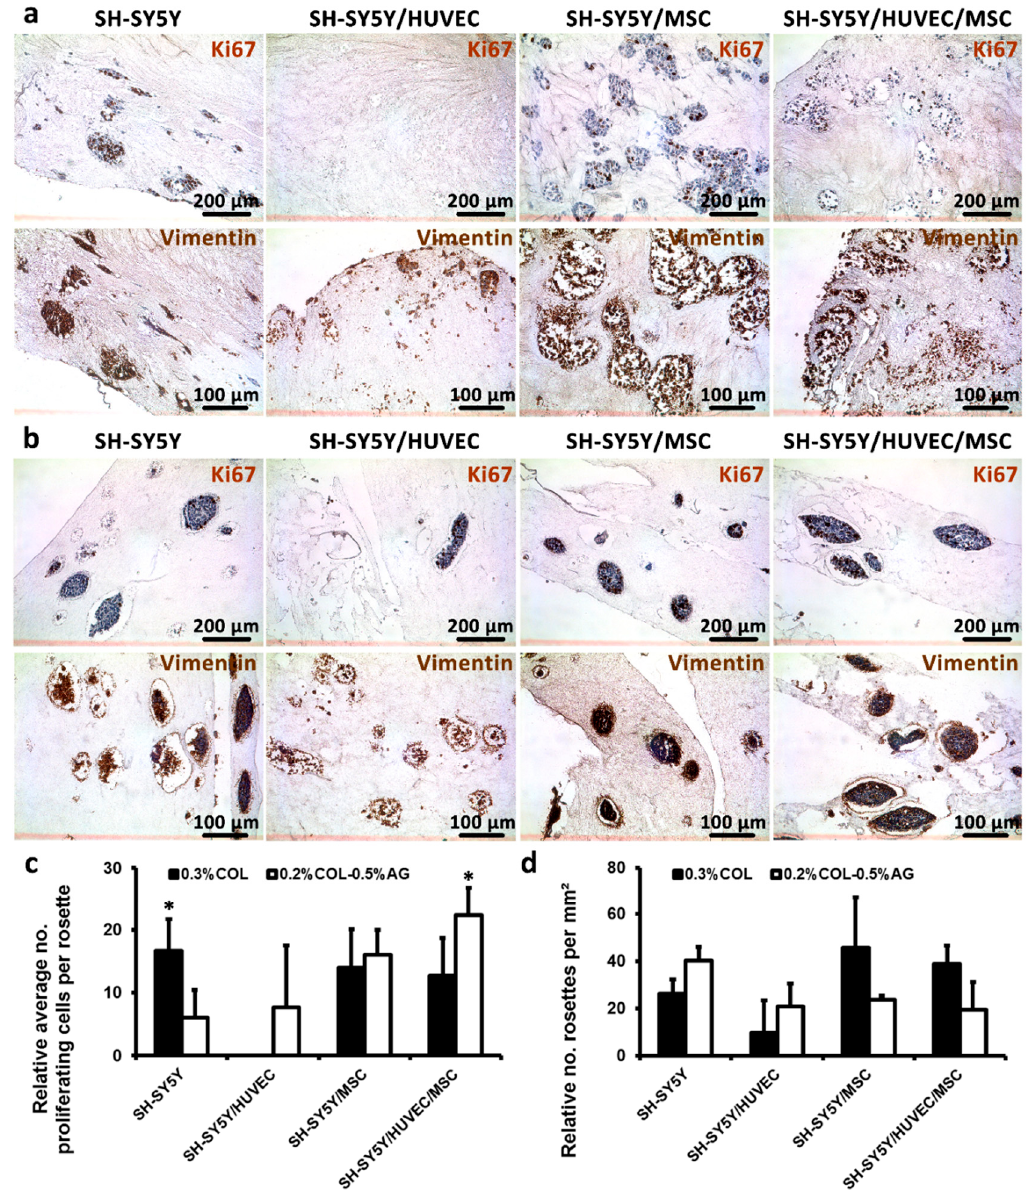
Figure 5. Analysis of cell proliferation, formation of rosettes in 3D hydrogels and expression of the mesenchymal marker vimentin. ( a – b ) First rows: cell proliferation was assessed by Ki67